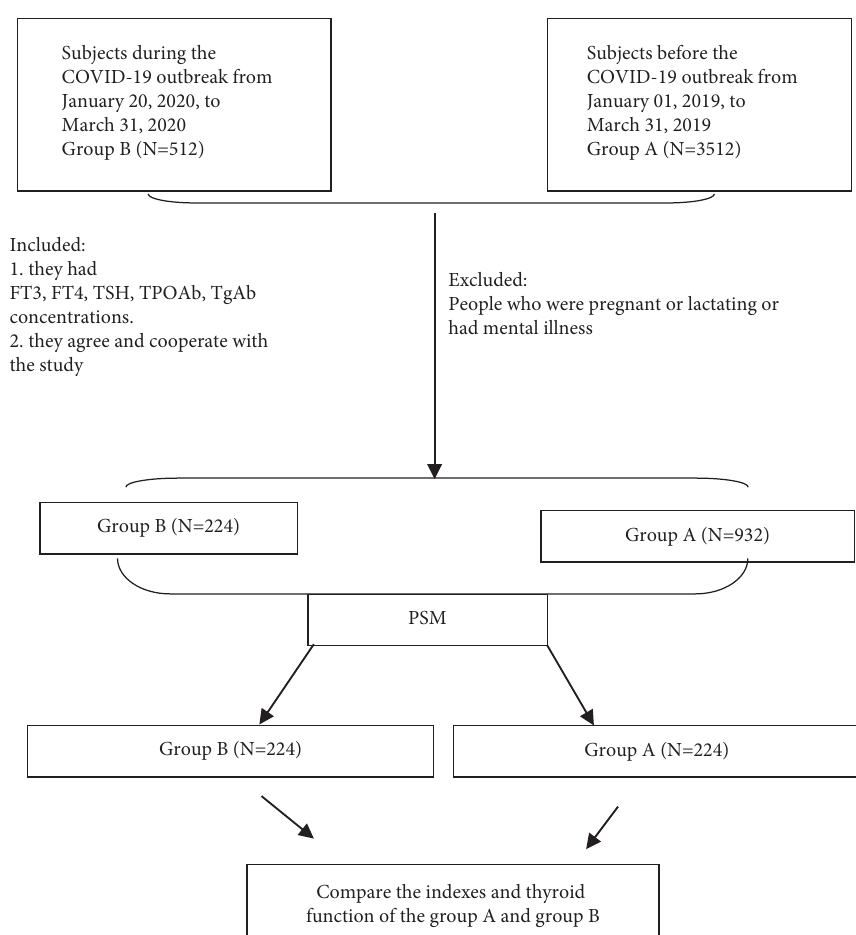
Figure 1: Flowchart illustrating the subjects’ selection and data availability.